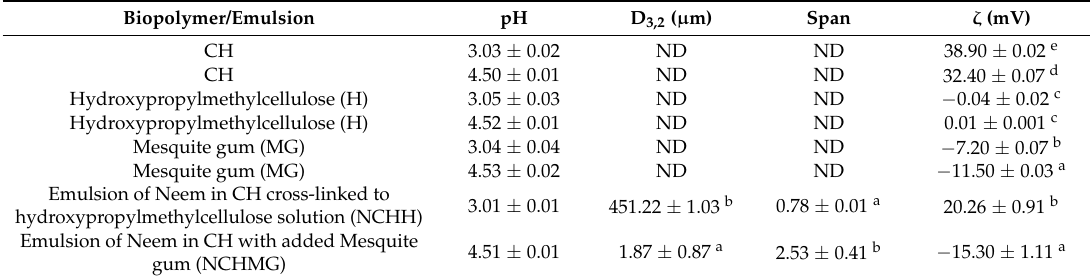
Table 1. Average Sauter diameter (D 3.2 ), dispersion index (Span), and zeta potential ( ζ ) of biopolymers and